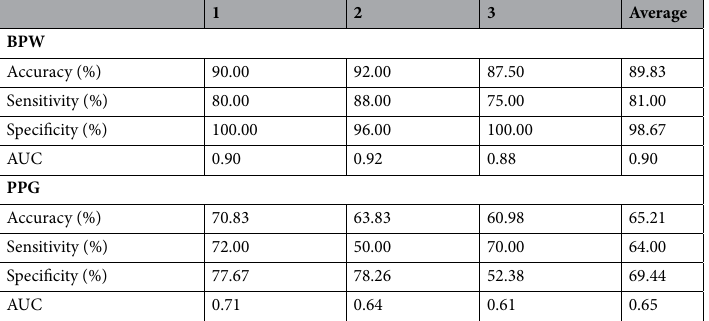
Table 2. MLP analysis results for comparisons of BPW and PPG indices between AD patients and control subjects. Training and validation results are presented for the threefold cross-validation. For BPW indices, there were 6247 and 6626 pulses for AD patients and control subjects, respectively. For PPG indices, there were 4673 and 4043 pulses for AD patients and control subjects, respectively.